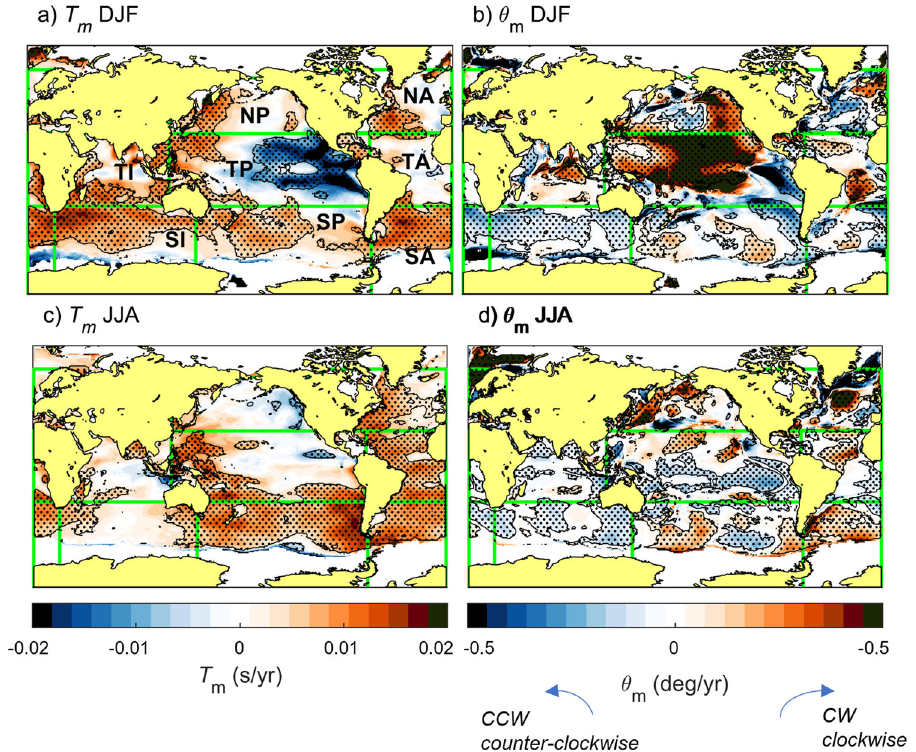
Fig. 5 Mean wave period trends ( T m ) based on the 5-member ensemble and mean wave direction ( θ m ) trends based on the 7-member ensemble for 1980 – 2014. a Median T m for DJF season, b median θ m for DJF season, c median T m for JJA season, d median θ m for JJA season. Stippling indicates regions of robust trends (multi-member ensemble mean > inter-member standard deviation; see the “ Methods ” section). See Fig. 4 for the de fi nition of large-scale ocean regions. Table 2 Ensemble mean trends (cm per year) and percent area experiencing robust signals of H s change for the DJF season. Region H 50 s DJF H 90 s DJF Positive trend (cm/yr) Negative trend (cm/yr) Positive trend